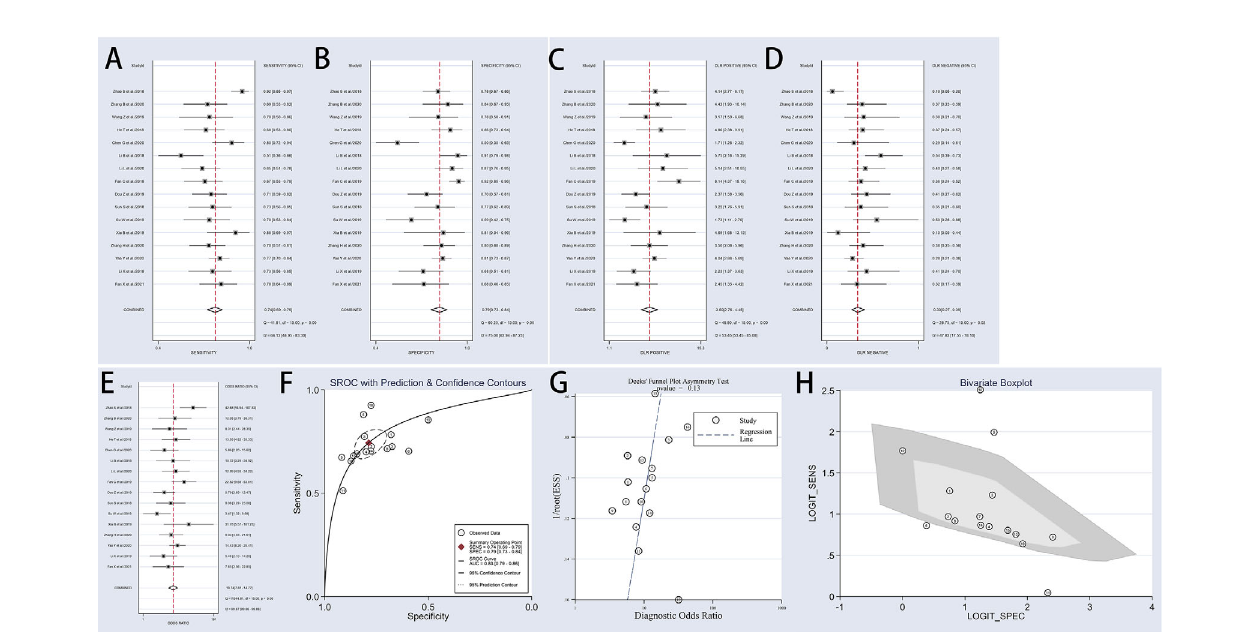
FIGURE 3 | Forest plots of sensitivity, speci fi city, PLR, NLR, DOR, AUC, and funnel plot for diagnosis of circRNAs in OSCC among 16 studies. (A) Sensitivity; (B) Speci fi city; (C) PLR; (D) NLR; (E) DOR; (F) AUC (SROC curve); (G) Deek ’ s funnel plot; and (H) Bivariate boxplot. OSCC, oral squamous cell carcinoma; PLR, positive likelihood ratio;NLR, negative likelihood ratio; DOR, diagnostics odds ratio; SROC, Summary receiver operator characteristics curve; AUC, the area under SROC